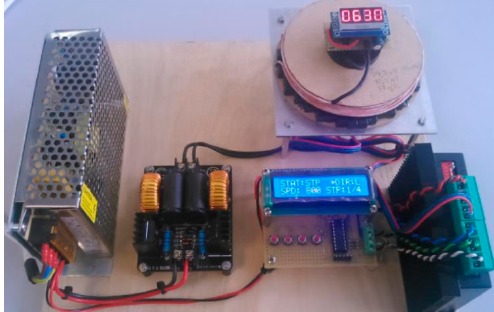
Figure 8. A PI with ED that was used for the realization of a contactless charging station of a